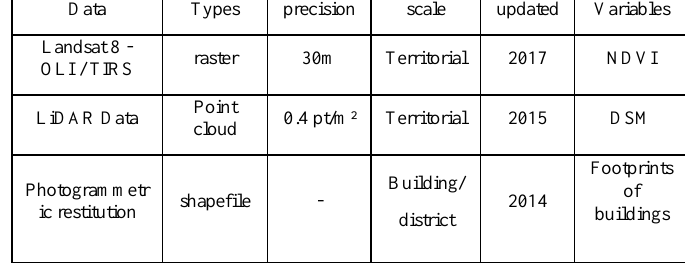
Table 1. Characteristics of the data and their collection sources